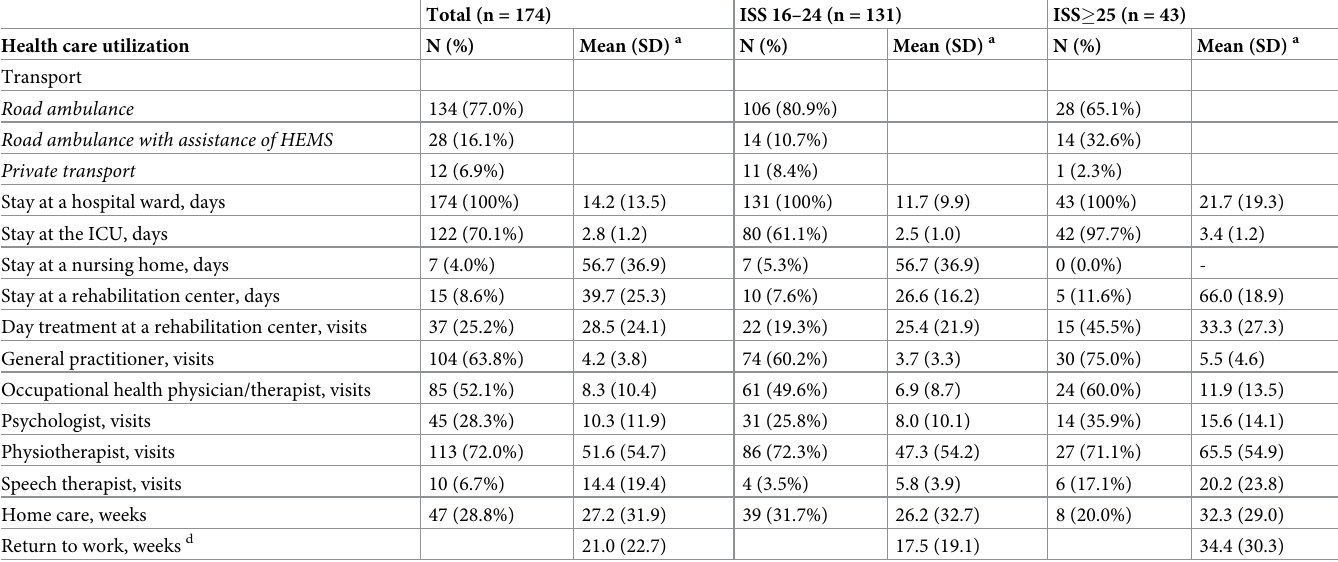
Table 2. Health care utilization by category of service of adult trauma patients (ISS �